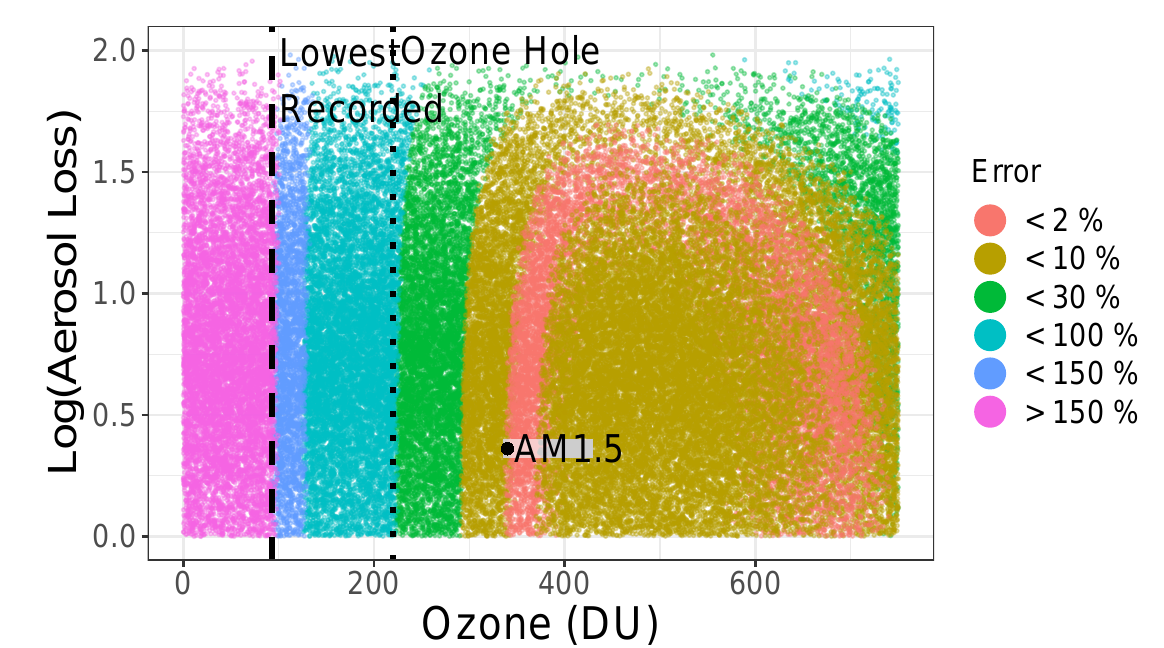
Figure 5. The error predicted by an atmospheric optical model (Equation (2)) for using the approximation UVI = 76.6 I 310 nm. We indicate the location of the standard conditions, AM1.5 Spectrum (Figure 1c) in this parameter space (black